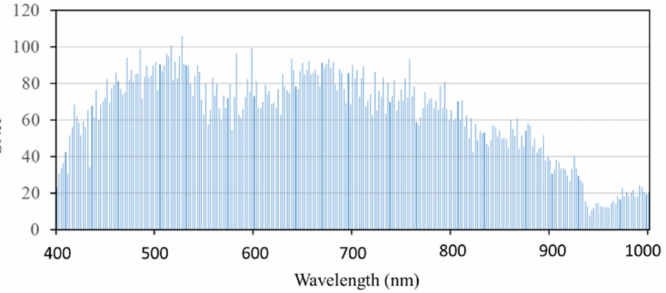
Figure 4. Signal-to-noise ratio of UAV hyperspectral remote sensing data covering calibration tarp. In this study, the difference between the mean reflectance of healthy rice and the mean reflectance of diseased rice (D-MRH&MRD), defined by Equation (3), was used to measure the sensitivity of each waveband. The higher the D-MRH&MRD, the stronger the sensitivity of the band to rice false